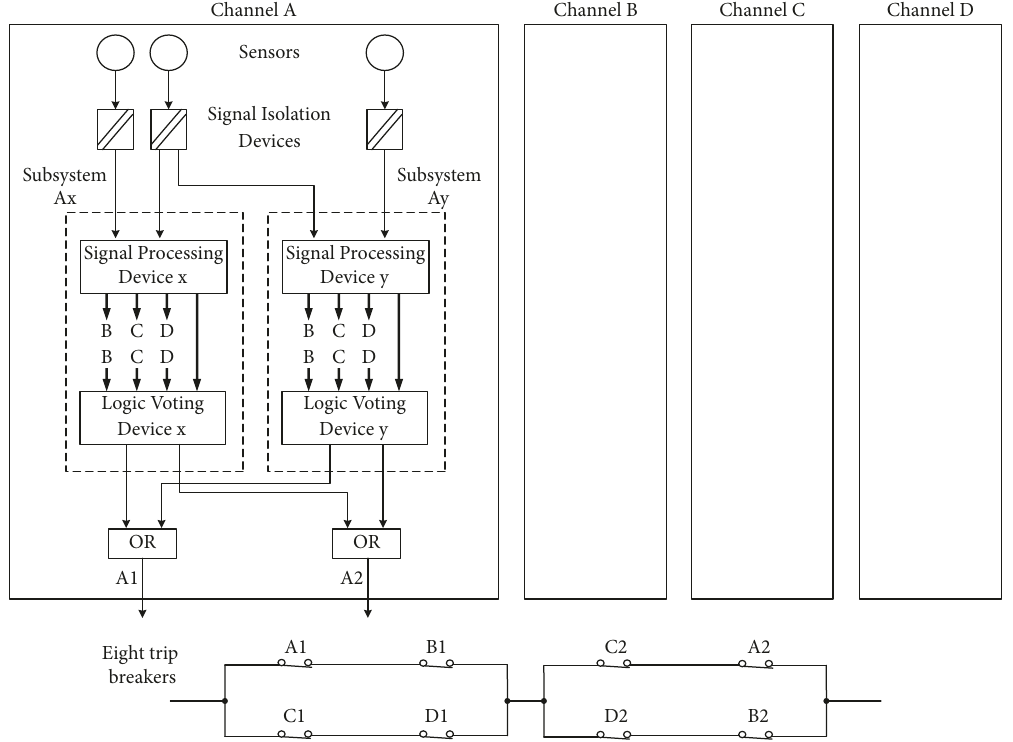
Figure 1: Architecture of the reactor protection system (RPS) in